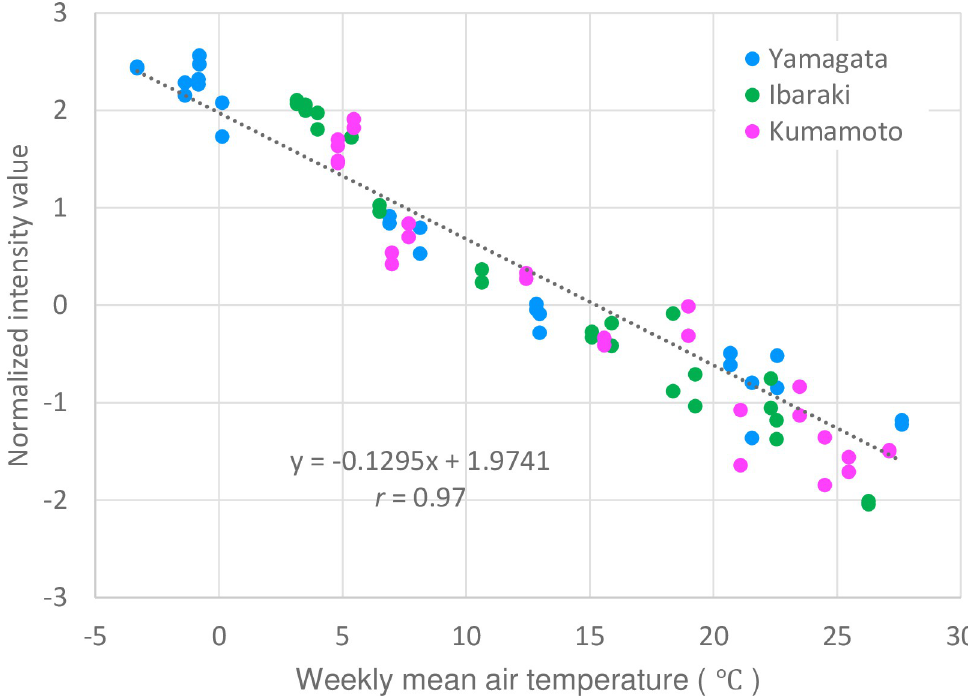
Fig 6. Correlation between 7-day mean air temperature and expression level of the gene encoding peptidase M20/ M25/M40 family protein.